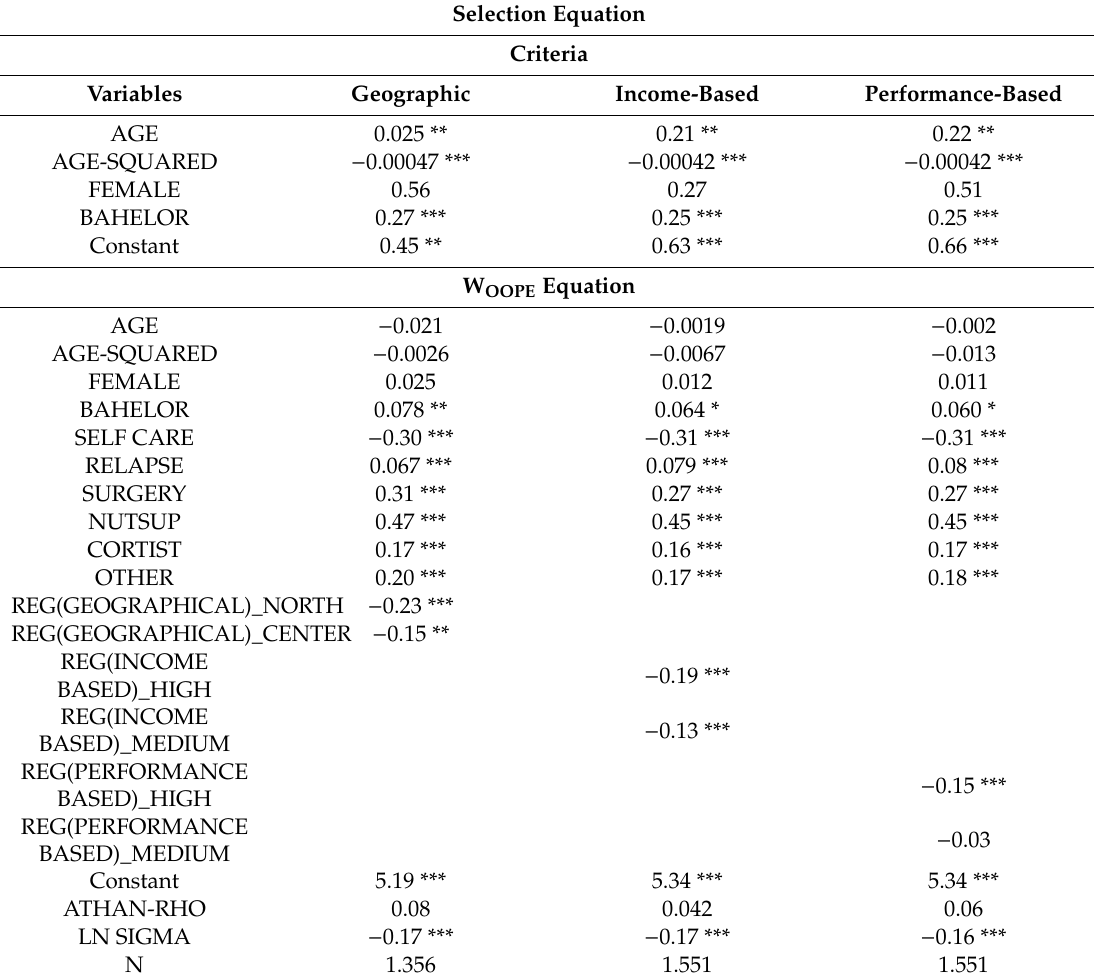
Table 3. Parametric